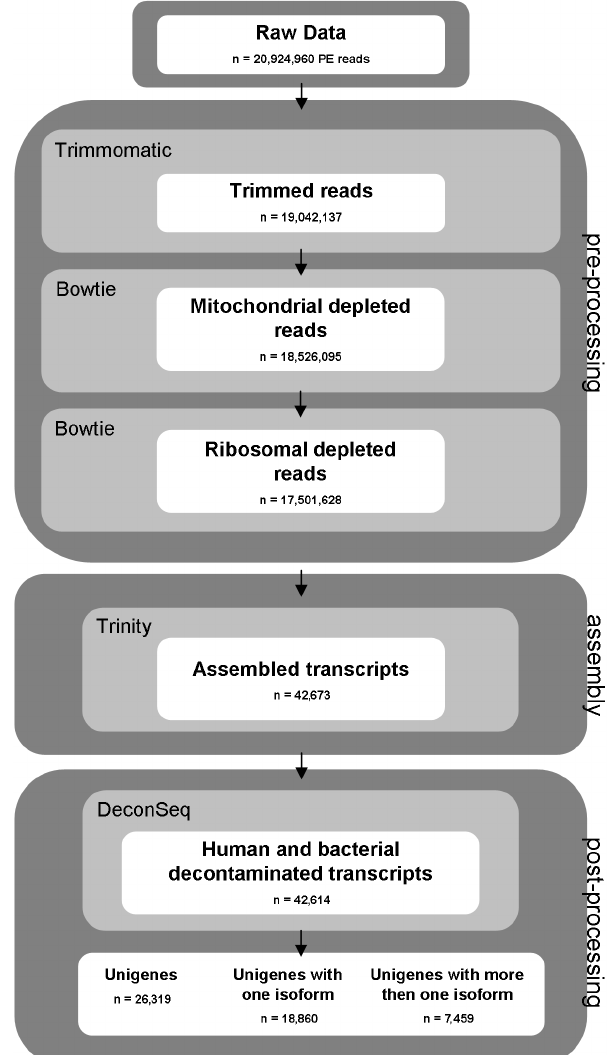
Figure 1. Filtering and assembling pipeline flowchart. Data files are represented as white boxes. Software utilized for each step are represented as light grey boxes while dark grey boxes represent the phases of the filtering and assembling